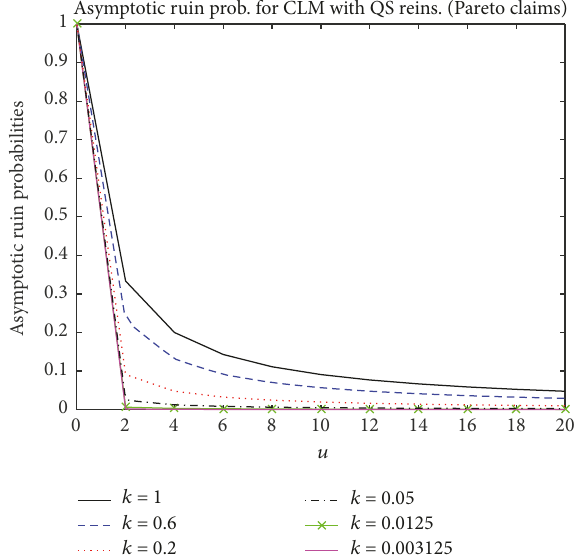
Figure 3: Asymptotic ruin probabilities for large claims in the CLM with proportional reinsurance ( 𝑐 = 6 , 𝜆 = 2 , 𝜃 = 𝜂 = 1